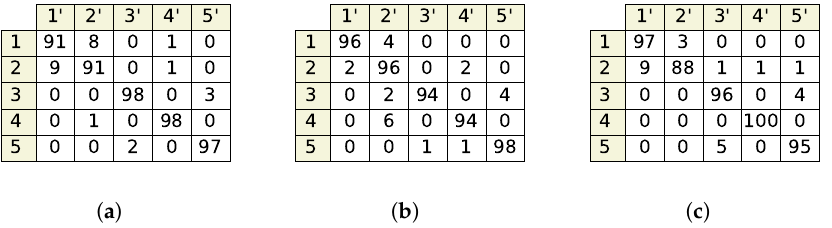
Figure 14. Cumulative confusion matrices for 10 validations of 50 feature sets with equal frequency in each class, { 1, . . . ,5 } —true classes, { 1 (cid:48) , . . . ,5 (cid:48) } —predicted classes, ( a ) LDA classifier, ( b ) RF classifier, ( c ) DNN classifier.